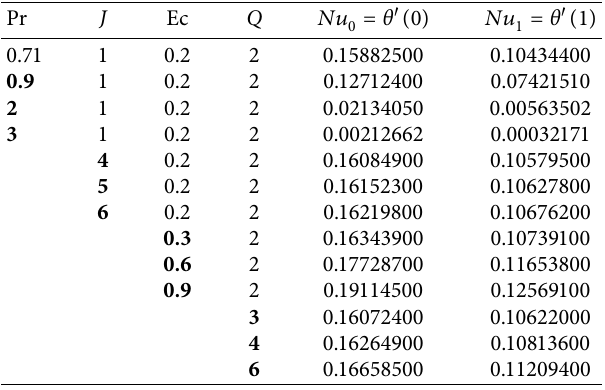
Table 1: Results of the Nusselt number for various values of physical parameters.